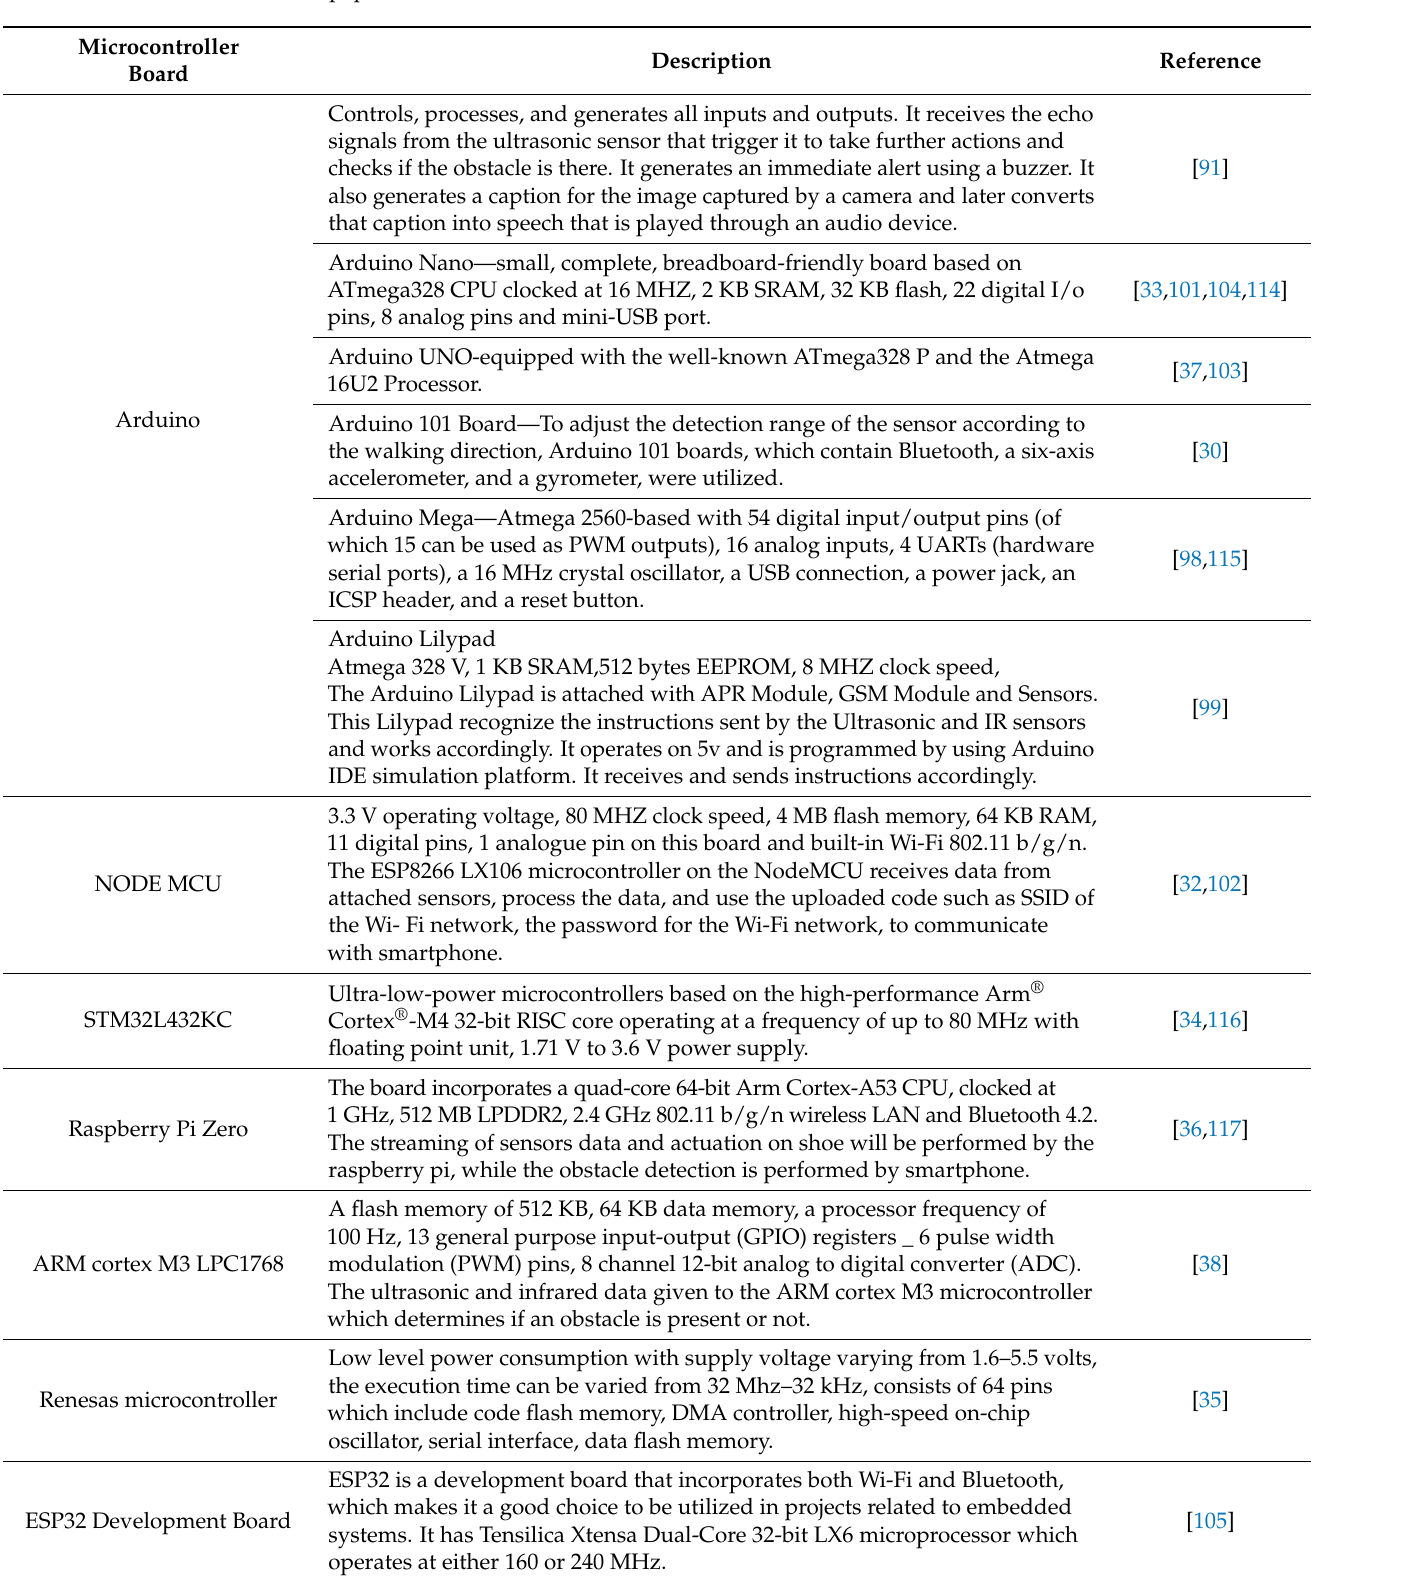
Table 6. Microcontroller boards used for obstacle detection shoes. The features are taken from the papers and